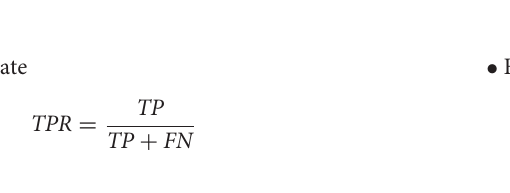
FIGURE 2 | Flowchart depicting the model development pipeline used in this